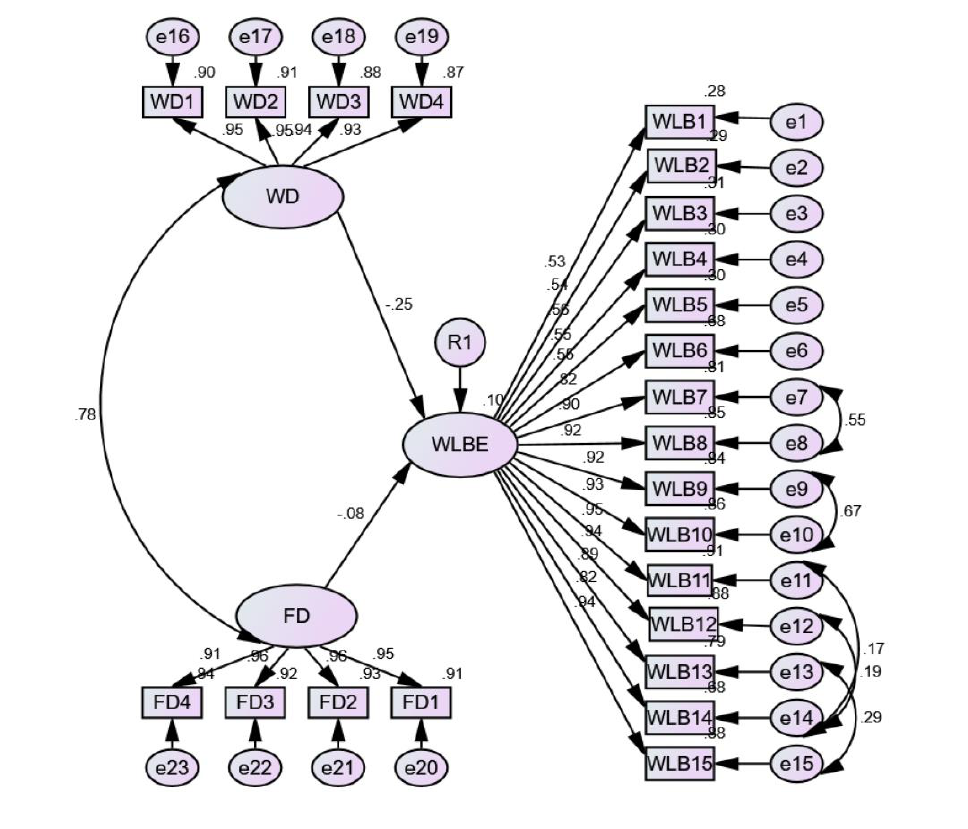
Figure 3: Results of the Structural Equation